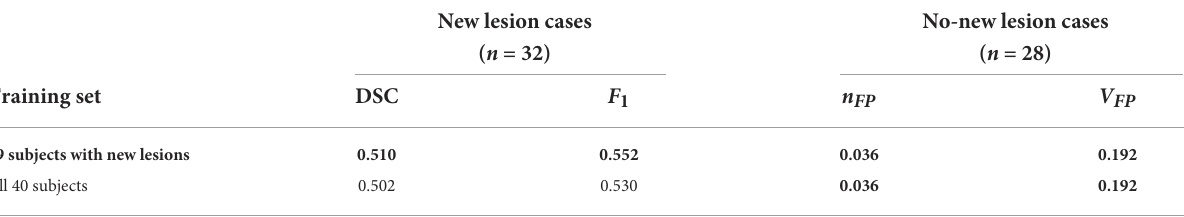
TABLE 4 Comparison between using the complete MSSEG-2 training set (40 subjects) against using 29 subjects which excludes the no new lesion